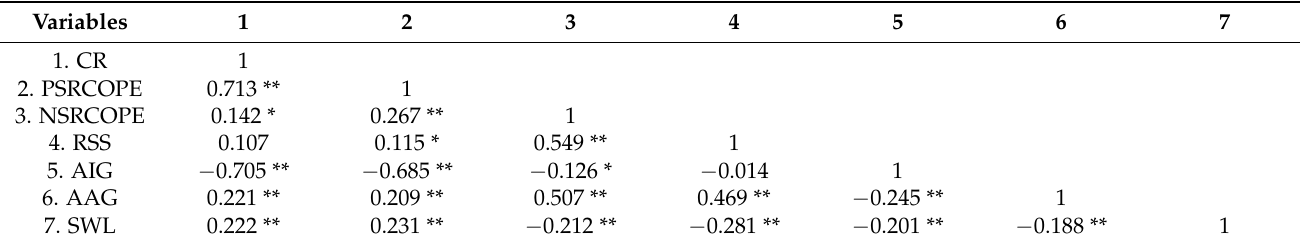
Table 1. Pearson correlations between study variables.